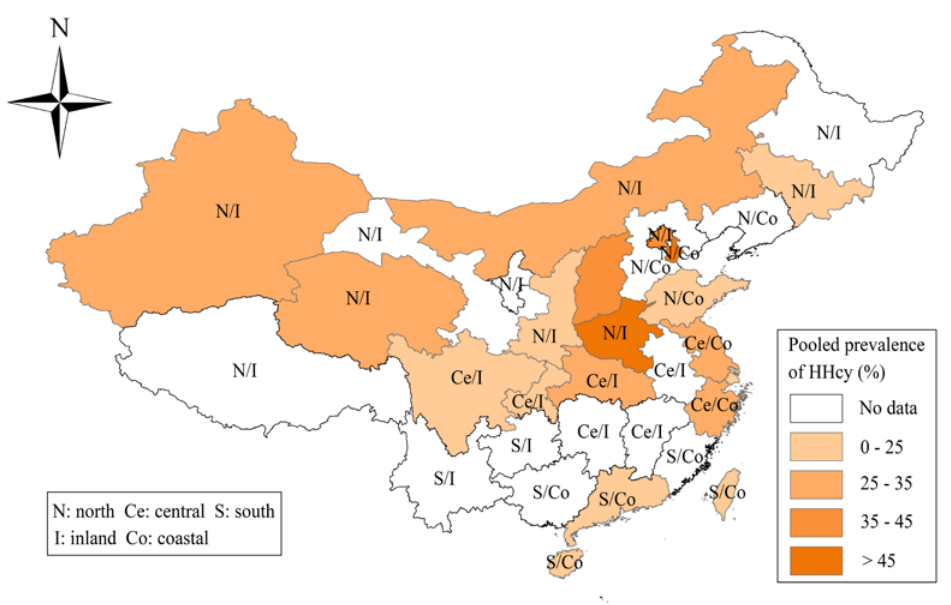
Figure 2. Provincial distribution pattern of pooled prevalence of hyperhomocysteinemia in